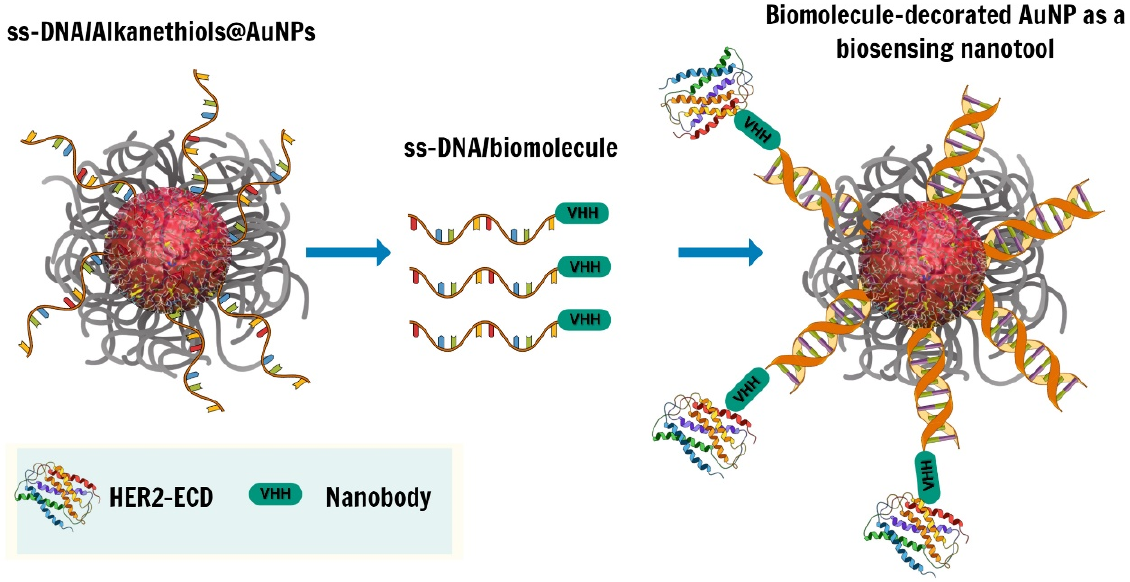
Figure 1. Schematic representation of the DNA-directed immobilization (DDI) strategy used in this work.